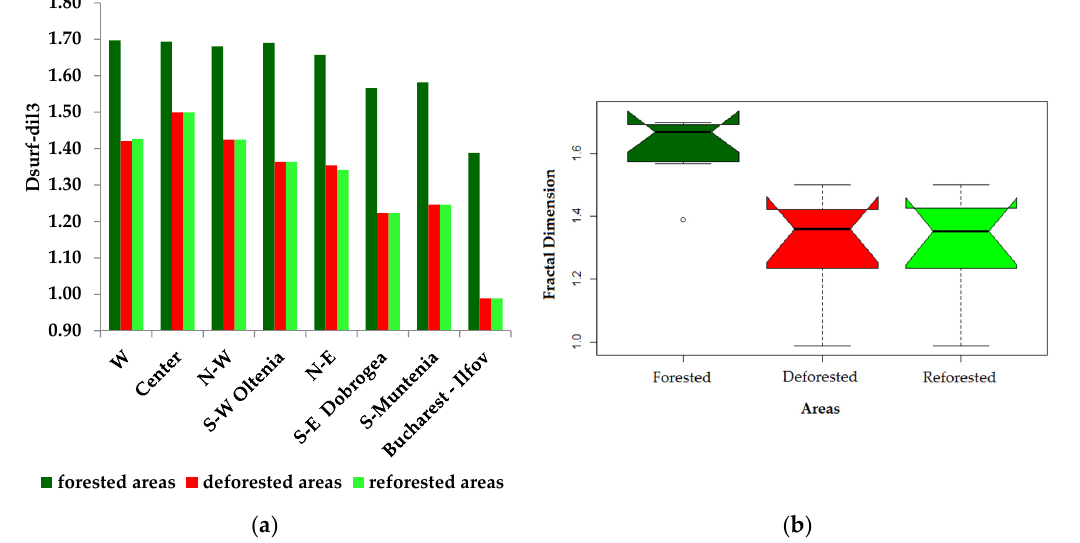
Figure 7. ( a ) D Surf ‐ dil3 of forested, deforested and reforested areas from development regions of Romania. ( b ) Boxplots with notches represent the median, interquartile range and extreme values of D Surf ‐ dil3 of forested, deforested and reforested areas from DRs of Romania.